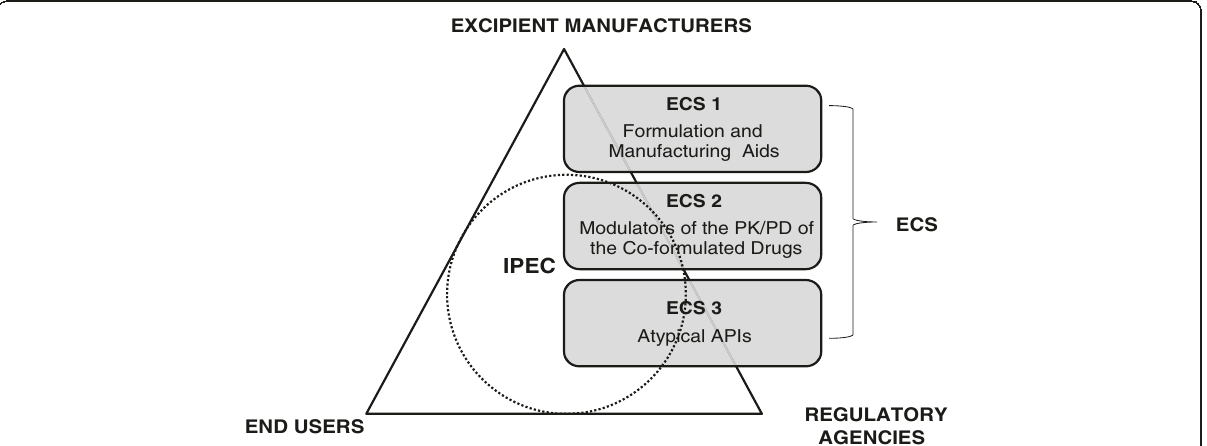
Fig. 2 Interplay between a proposed Excipient Classification System (ECS) and major stakeholders. IPEC designates International Pharmaceutical Excipients Council and API active pharmaceutical